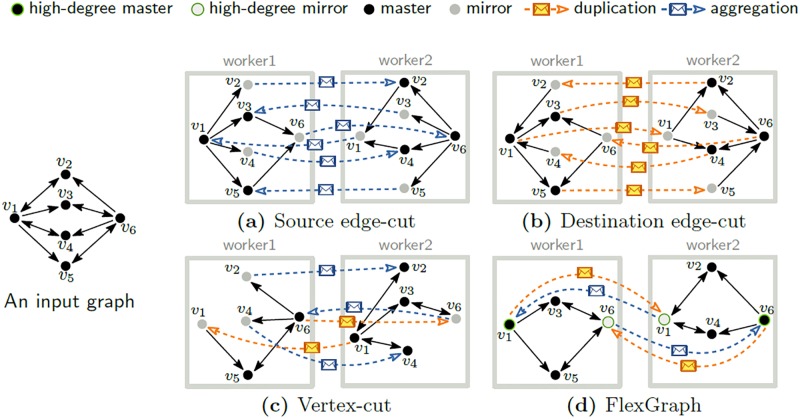
Effects of flexible edge placement.(a) If we use source edge-cut, a worker who has high out-degree vertex produces massive aggregation messages because many mirrors of outgoing neighbors are in other workers. (b) Even if we use destination edge-cut, the number of messages does not decrease much because there are many duplication messages from many mirrors of incoming neighbors in other workers. (c) Vertex-cut reduces the number of messages by reducing the number of mirrors. However, computing the optimal vertex-cut is NP-hard [54, 55], and computing an approximate solution requires shared data between workers, or massive pre-computation time [56]. (d) Our method exploits source edge-cut for low out-degree vertices to reduce duplication messages from a large number of low out-degree vertices, and destination edge-cut for high out-degree vertices to suppress aggregation messages caused by high out-degree vertices.